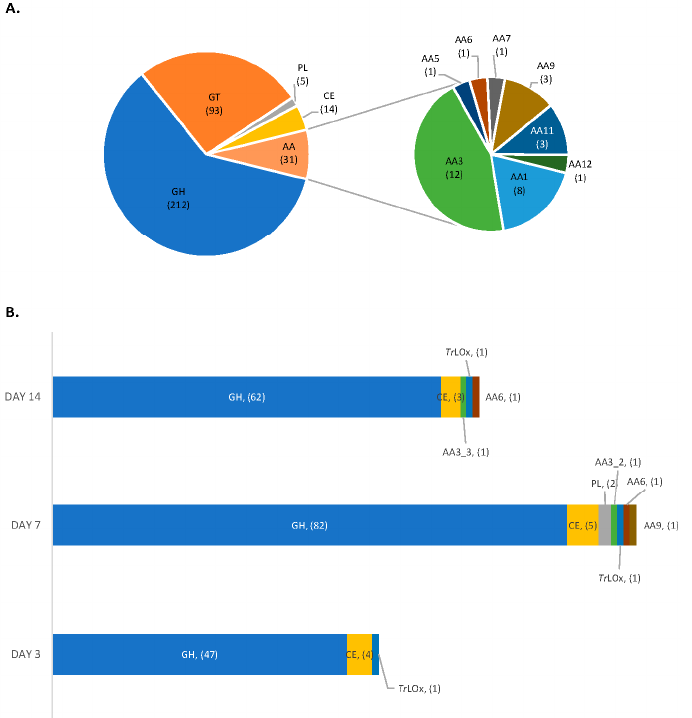
Figure 2. Distribution of CAZymes in genome and secretome of T. reesei . ( A ) genome and ( B ) secre- tome of T. reesei on lignin at days 3, 7 and 14 of growth. AA, auxiliary activity enzymes; GH, glycoside hydrolases; GT, glycosyl transferases; PL, polysaccharide lyases; CE, carbohydrate esterases; AA1, multicopper oxidases; AA2, class II lignin-modifying peroxidases; AA3, glucose-methanol-choline (GMC) oxidoreductases; AA3_2, aryl alcohol oxidase and glucose 1-oxidase; AA3_3, alcohol oxidase; AA5, copper radical oxidases; AA6, 1,4-benzoquinone reductase; AA7, glucooligosaccharide oxidases; AA9, AA11 and AA14 lytic polysaccharide monooxygenases; AA12, pyrroloquinoline quinone-dependent oxidoreductase; Tr LOx, lignin copper oxidase. Out of the 31 predicted auxiliary activity CAZymes in the genome of T. reesei